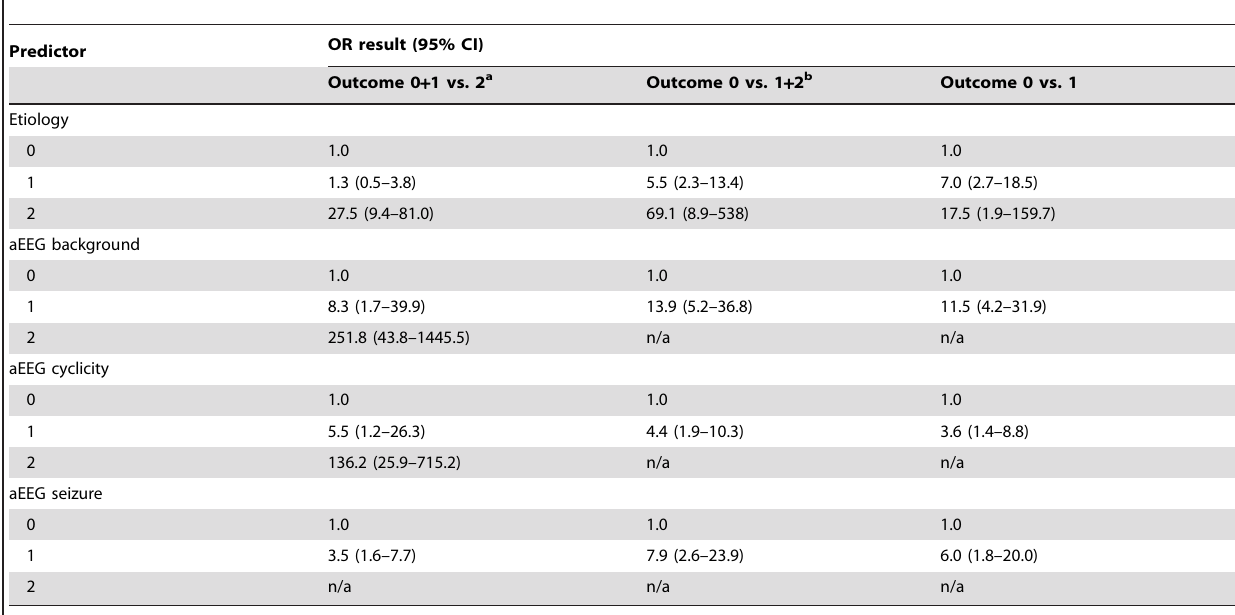
Table 3. The odds ratio (OR) of aEEG and etiology scores associated with outcome findings at the age of one year.